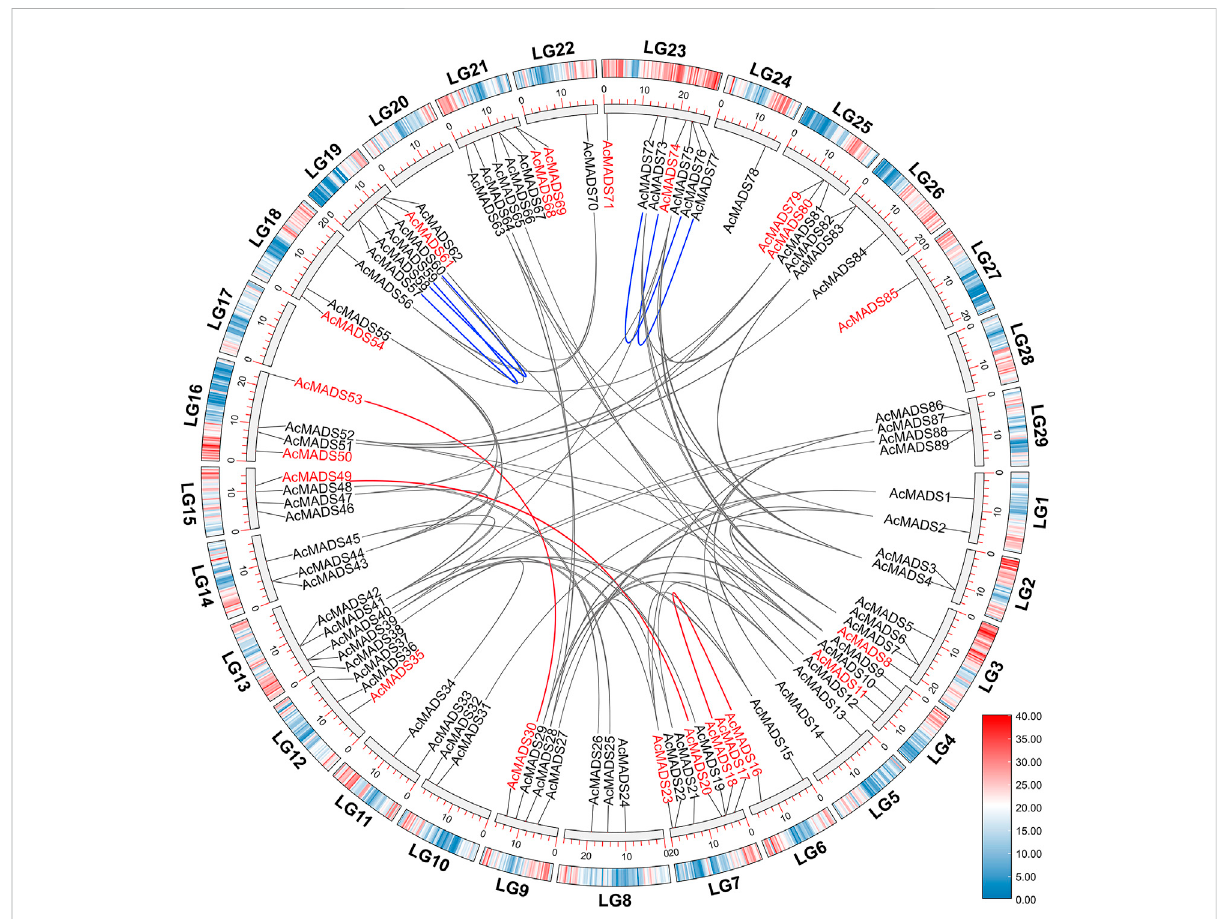
FIGURE 6 Synteny analysis of AcMADS-box genes in A. chinensis. The genes name in red and black represent type I and type II AcMADS-box genes, respectively. Gray and red lines represent inter-chromosomal synteny blocks in type I and type II AcMADS-box genes, respectively. The blue